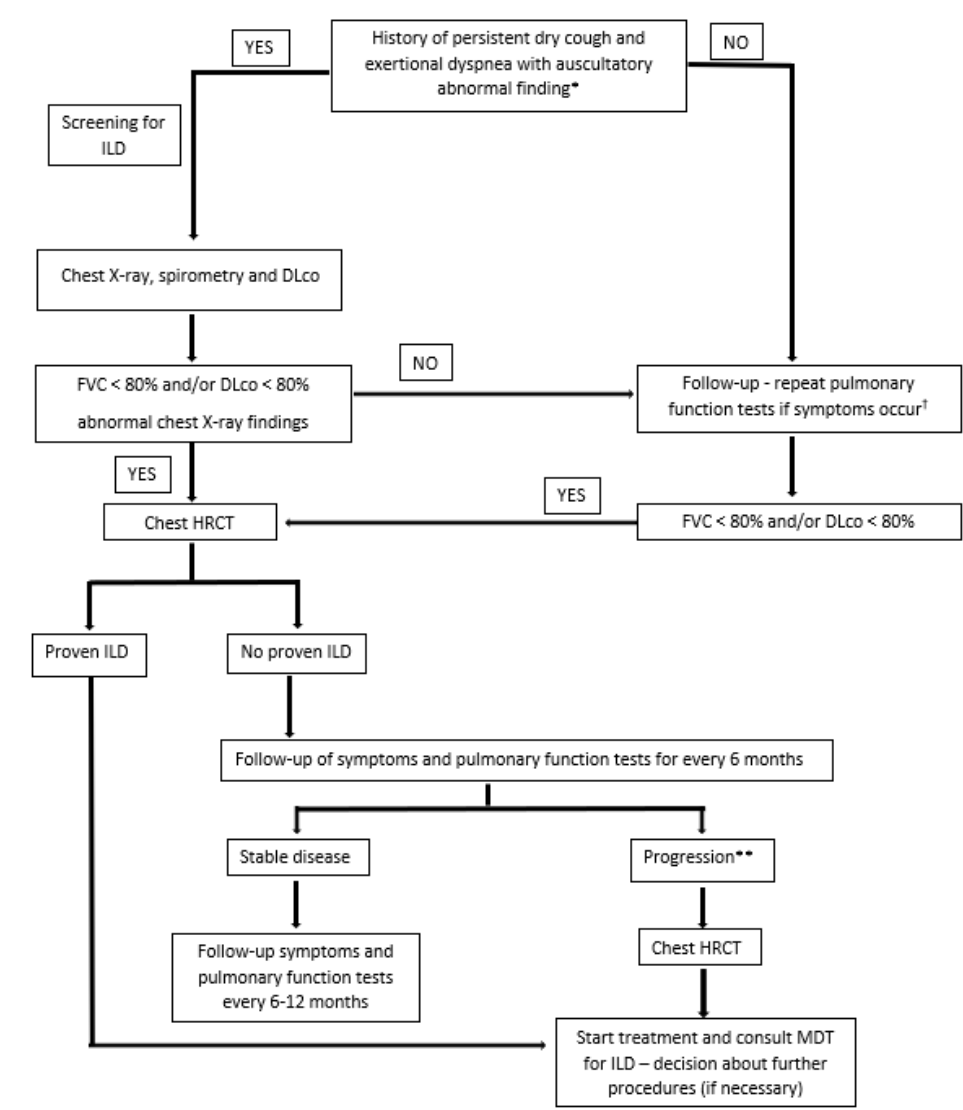
Figure 2. Screening for ILD in newly discovered RA, pSS, or SLE patients. Abbreviations: DLco, diffusion capacity for carbon monoxide; FVC, forced vital capacity; ILD, interstitial lung disease; HRCT, high-resolution computed tomography; MDT; multidisciplinary team; pSS, primary Sjögren’s syndrome; RA, rheumatoid arthritis; SLE, systemic lupus erythematosus. * In patients with identified risk factors include HRCT as screening methods. ** Clinical deterioration and/or decrease in FVC or DLco below 80% or by more than chest x compared to previous findings. † Most common symptoms include shortness of breath, exertional dyspnea, dry cough without phlegm, and weakness/extreme fatigue. Other symptoms include loss of appetite, unexplained weight loss, chest discomfort, dyspnea, tachypnea, and pulmonary hemorrhage.